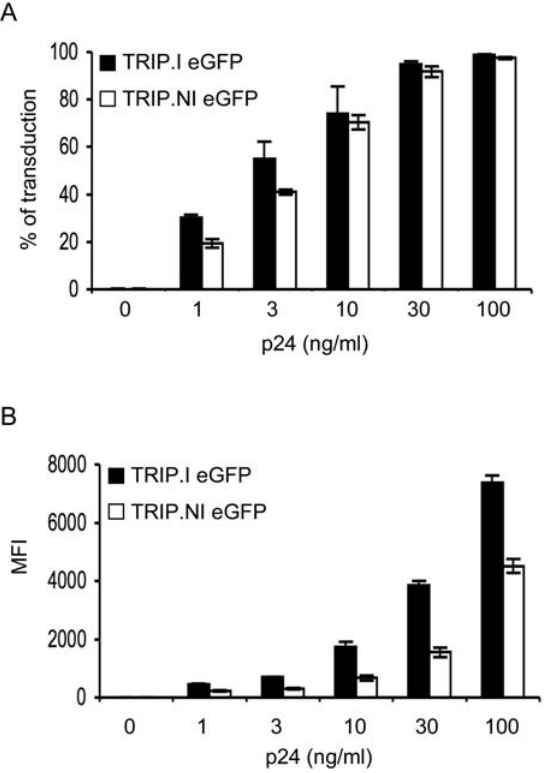
Figure 1. Efficient transduction of non-dividing cells with lentiviral vectors defective for integration. Aphidicolin-treated HeLa cells were transduced with graded doses (1–100 ng of p24 antigen) of eGFP-integrative vectors (TRIP.I eGFP) or eGFP-nonintegra- tive vectors (TRIP.NI eGFP). FACS analysis of the percentage of GFP positive cells (A) and the MFI (B) at 48 hours post-transduction is shown.